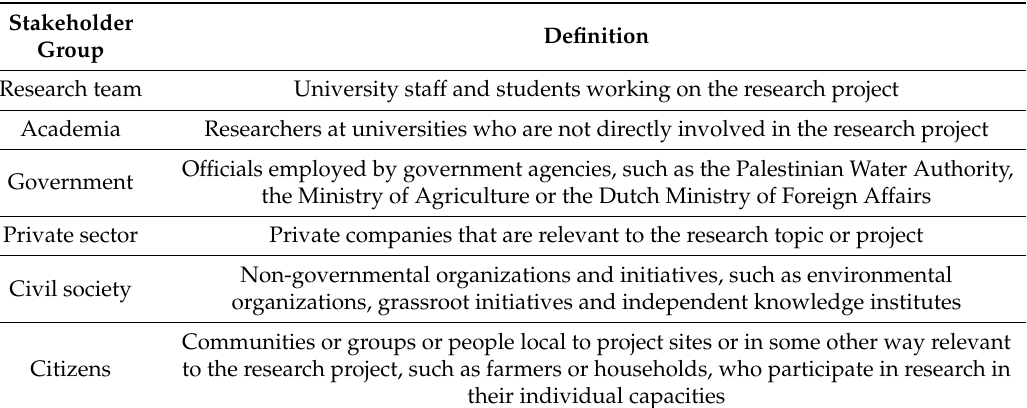
Table 2. Definition of different stakeholder groups used in the survey.